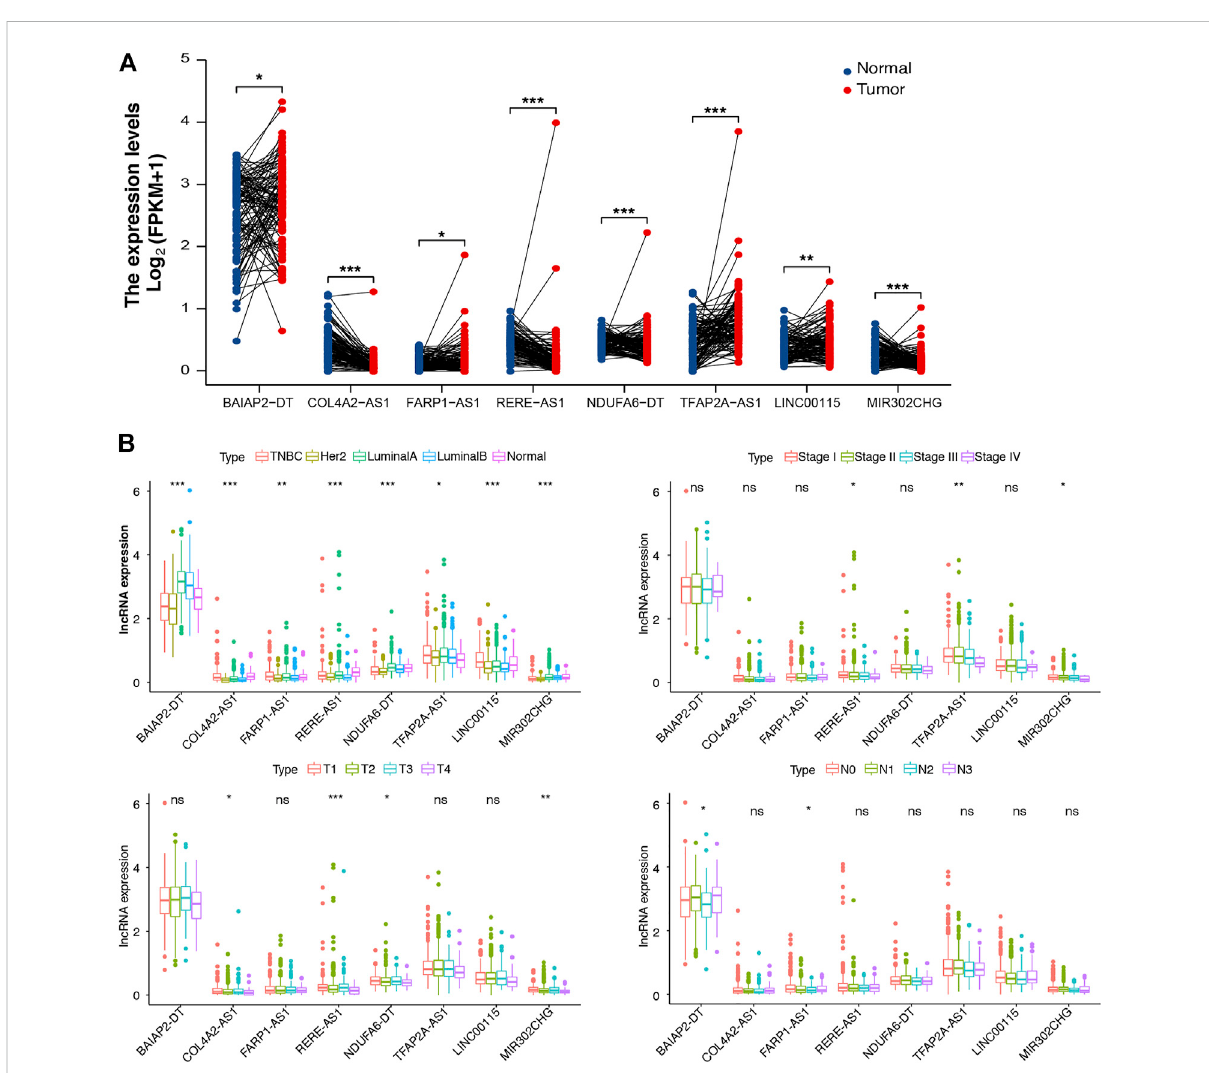
FIGURE 3 Differential expression analysis ofm7G-associated lncRNAs (m7G-lncRNAs). (A) Apaired differentialexpressionanalysis of theeightprognosis- related m7G-lncRNAs in normal and breast cancer (BC) tissues. (B) Differential expression analysis of m7G-lncRNAs in BC tissues according to molecular subtype, histological stage, T stage, and N stage (ns: not signi fi cant; * p < 0.05; * * p < 0.01; * * * p <